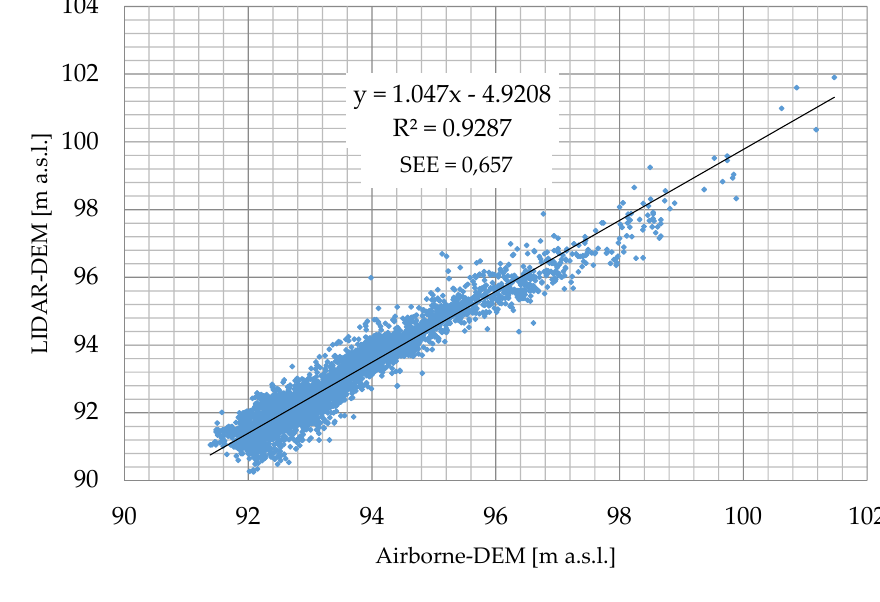
Figure 12. Cont. Figure 12. Cont